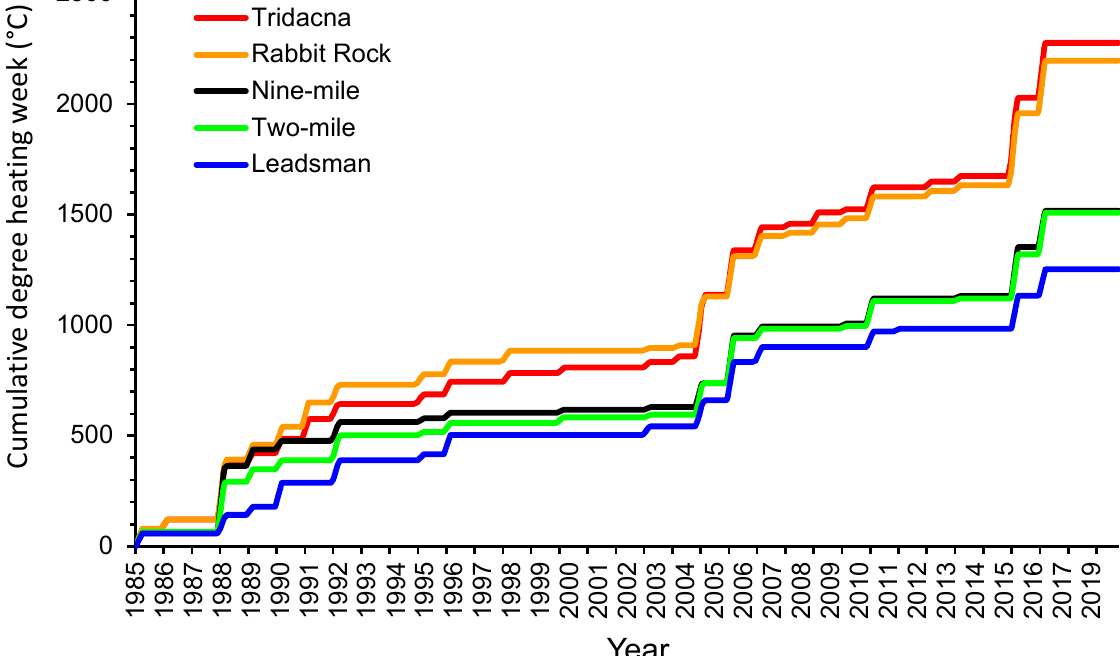
Figure 2. Cumulative daily degree heating weeks (°C) for several sites spanning the Northern, Central and Southern Reef Complexes in Maputaland, South Africa.